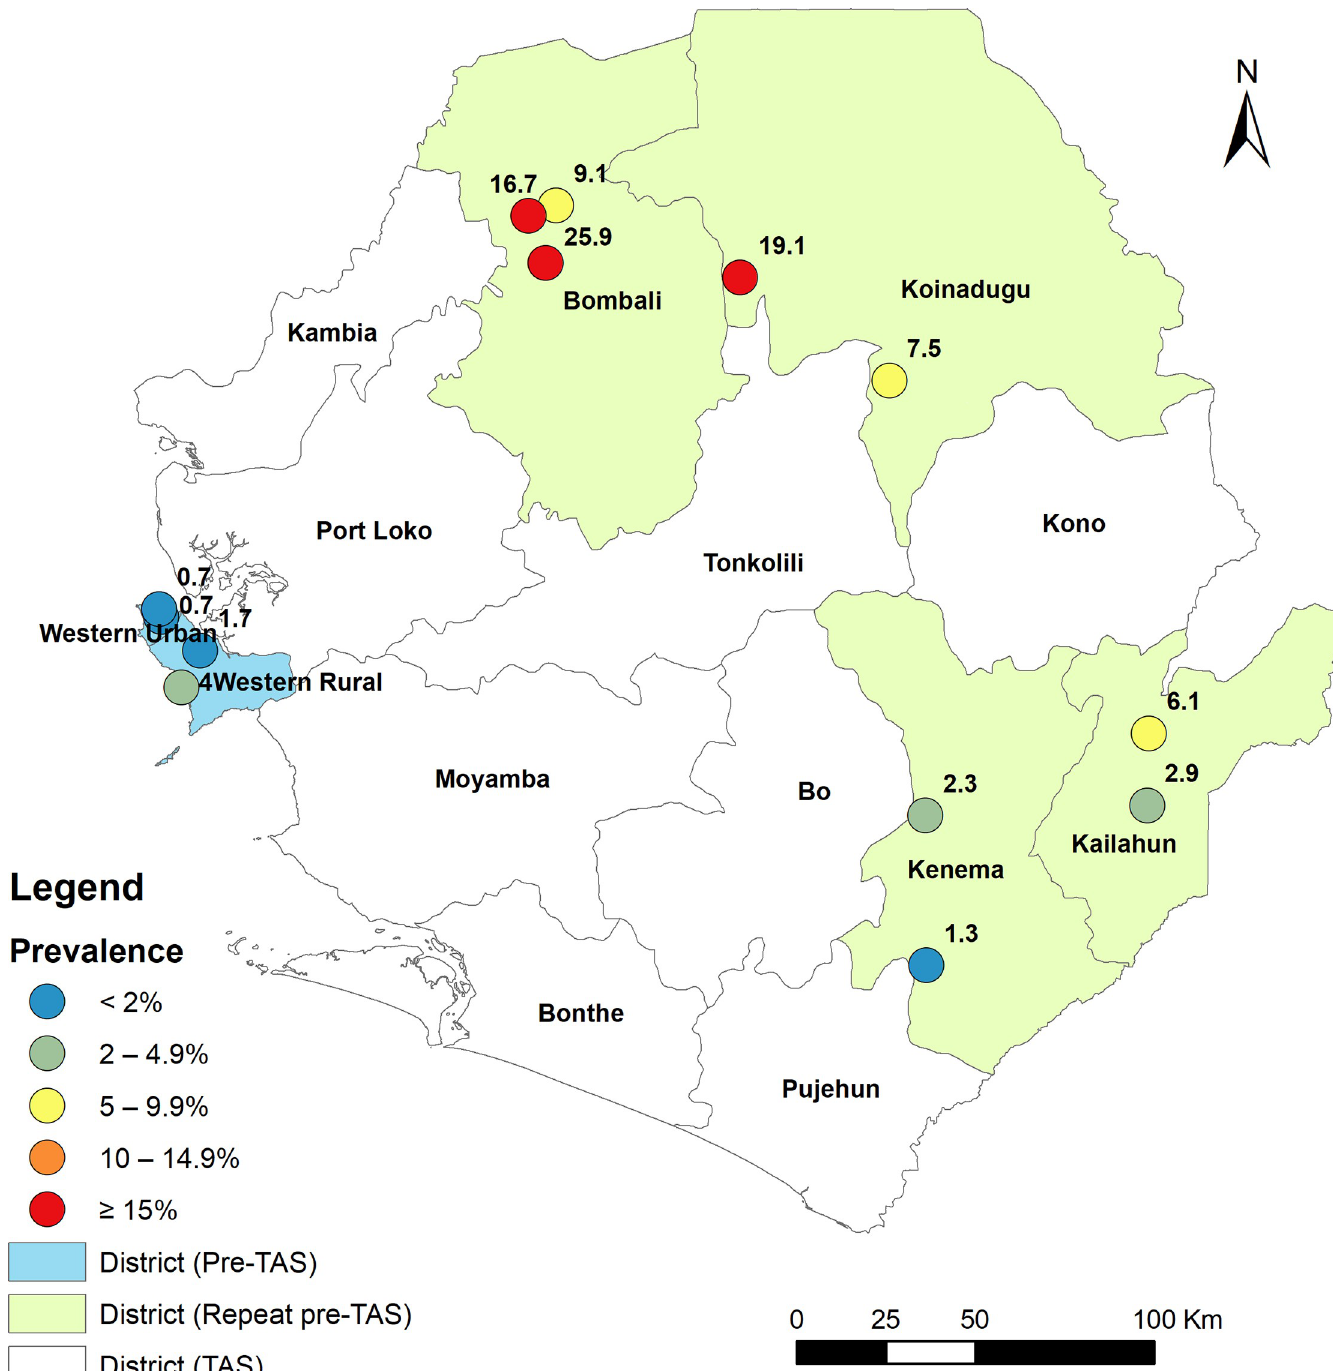
Fig 3. Location of repeat pre-TAS and pre-TAS survey sites and point-prevalence of FTS positives in 6 districts in Sierra Leone in 2017.